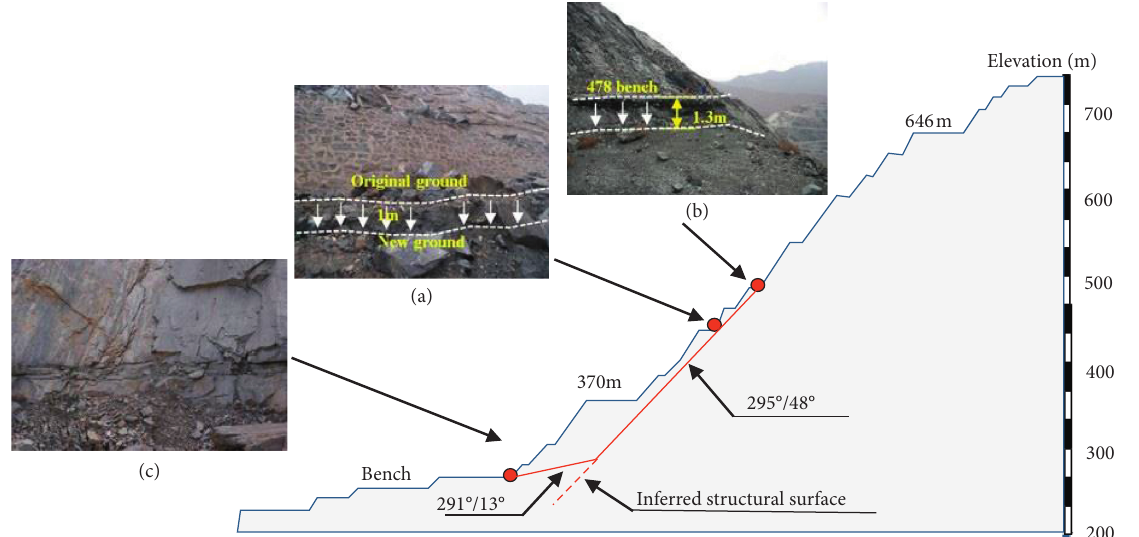
Figure 3: Images showing two sets of joints in the footwall at the Nanfen open-pit iron mine. (a) The failure characteristic on the top of bench with an elevation of 478m, and the attitude of structural surface is 295 ° /48 ° . (b) The failure characteristic on the top of bench with an elevation of 430m. (c) Structural surface exposed on the bottom of the bench with an elevation of 274m, and the attitude of structural surface is 291 ° /13 °